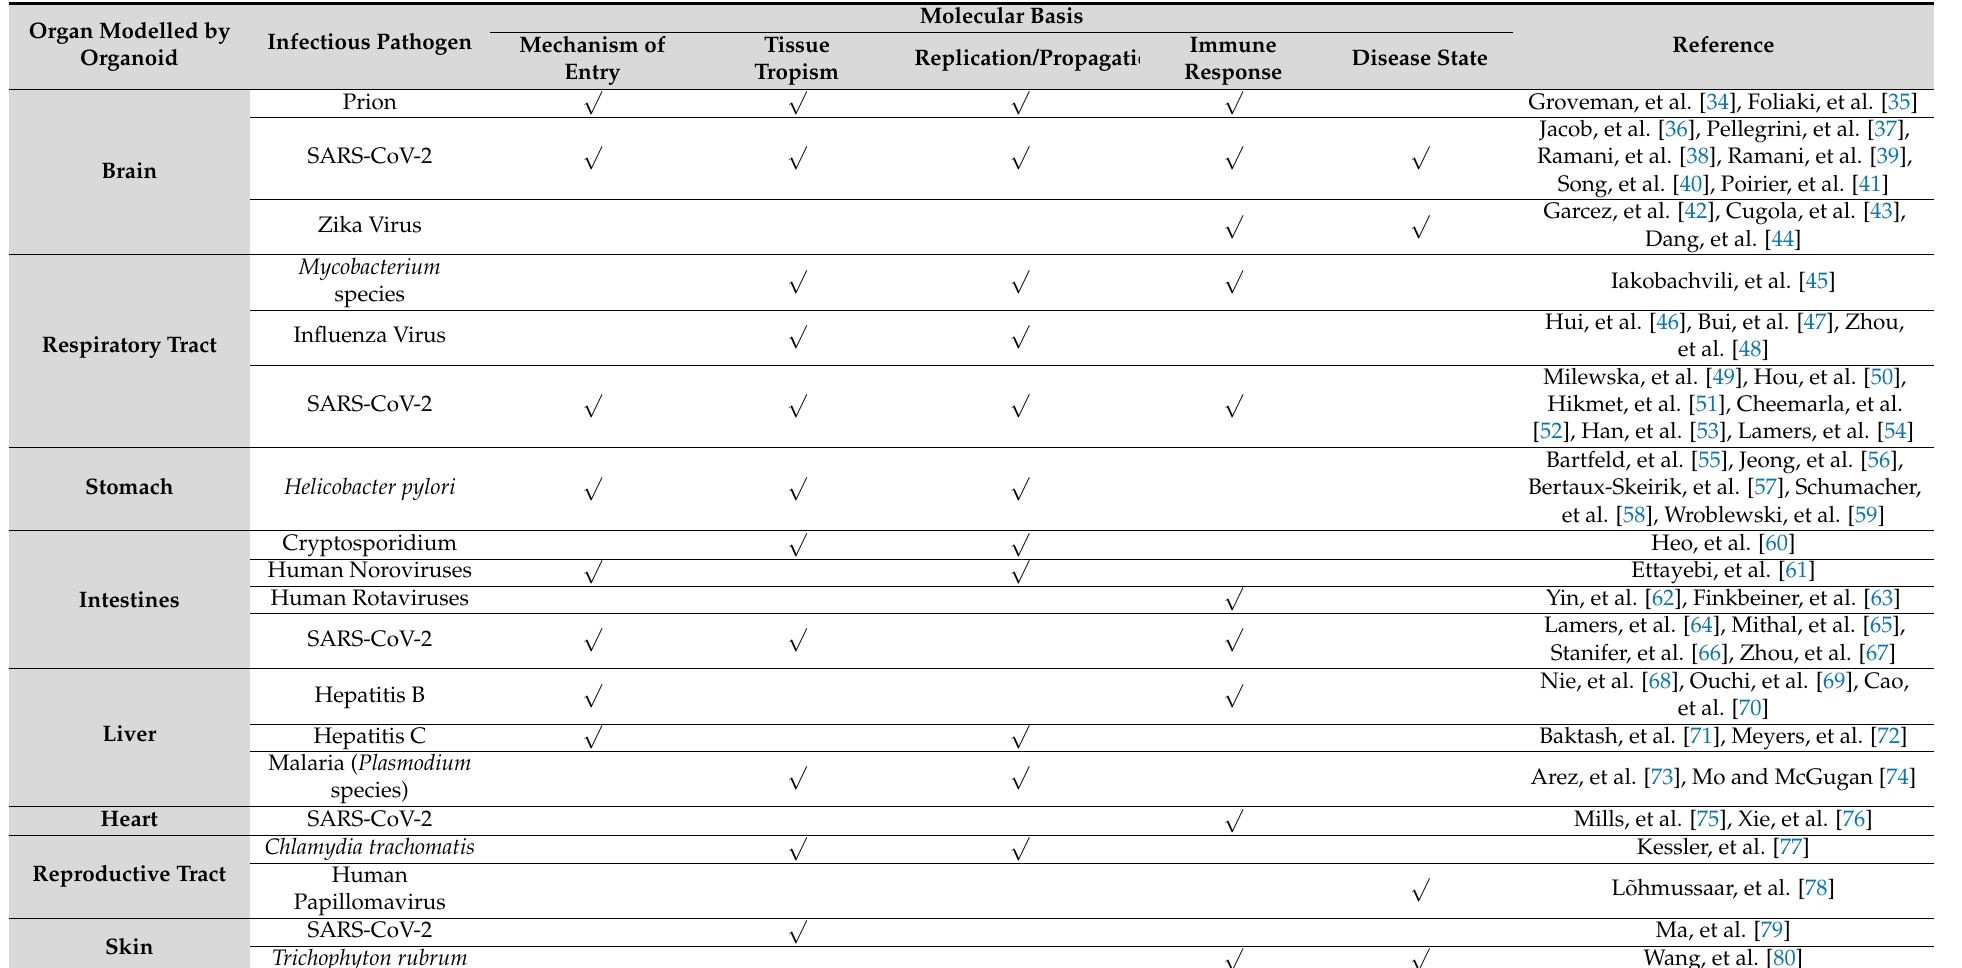
Table 2. Summary of the key findings of the molecular basis of infectious disease using the organoid